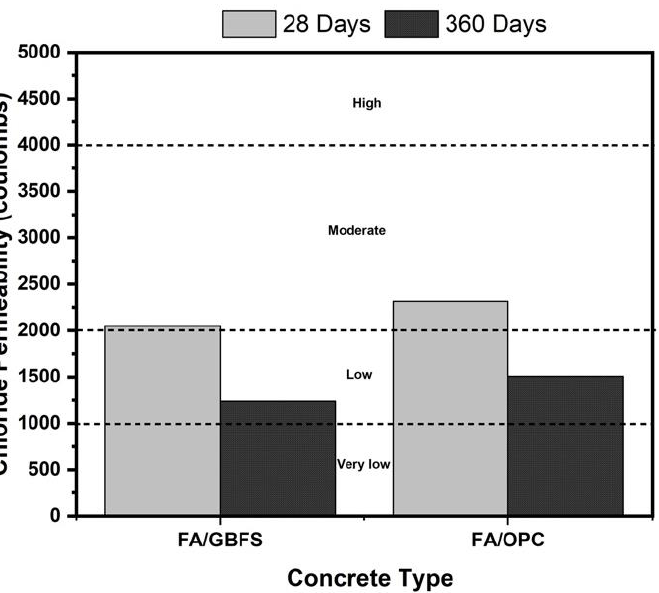
Figure 5. Rapid chloride permeability of FA/GBFS, FA/OPC concretes at 28 and 360 curing days.